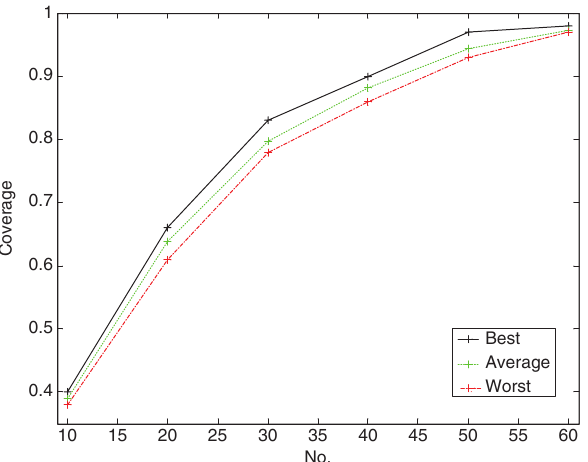
Figure 16: The Line Chart of the Coverage Rate with the Number of Nodes Changing.